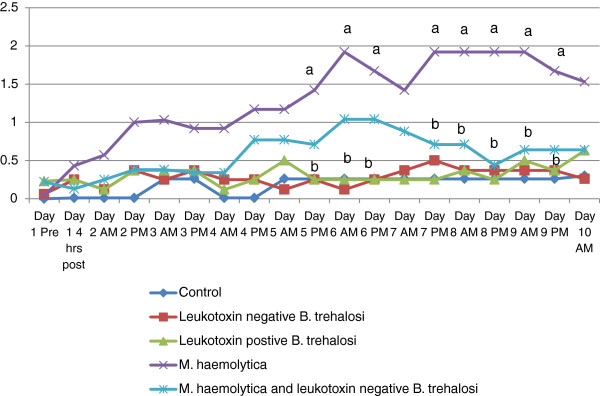
Depression score over time by Treatment group. Line graph of depression score by treatment group for each time point when depression score was recorded. Time points that were statistically different are indicated by different letters (a or b).